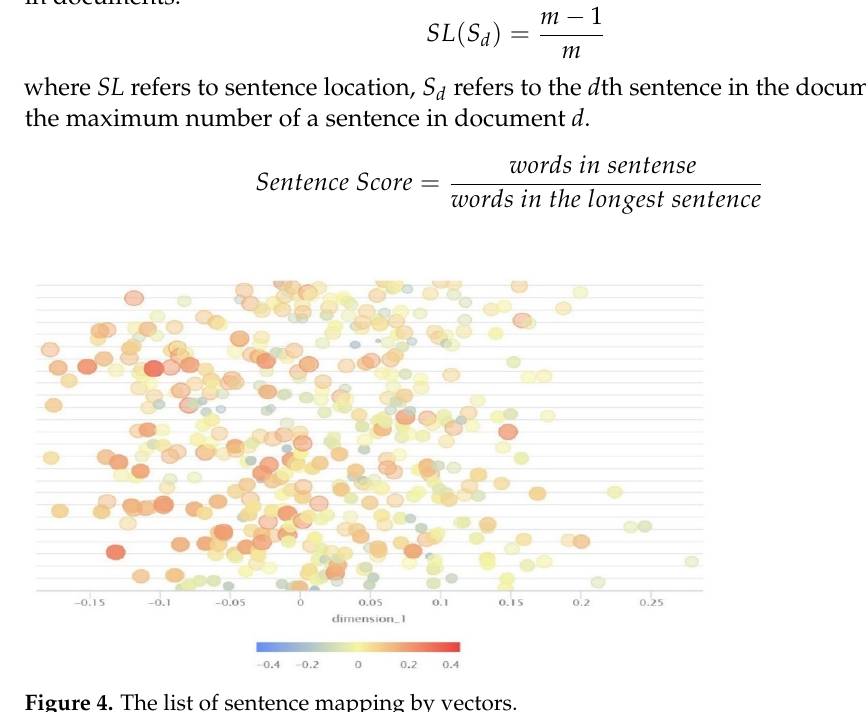
Figure 4. The list of sentence mapping by